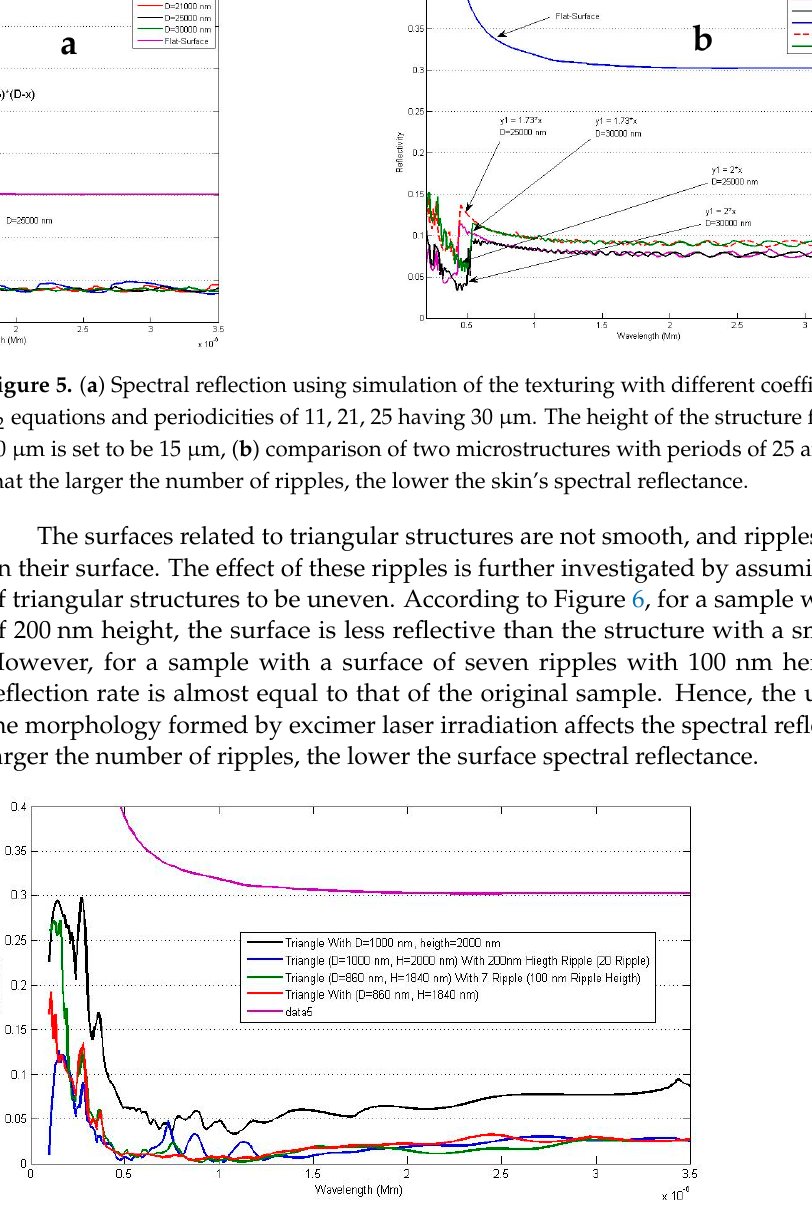
Figure 7. ( a ) Schemes of height distribution of triangular microstructure, ( b ) Spectral reflection based on the base size and height of triangular microstructures.